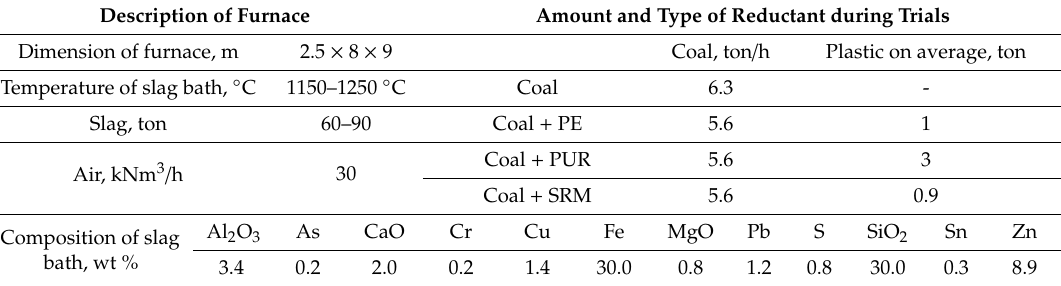
Table 2. The description of the furnace and the process parameters; slag was not analyzed for all the possible elements.